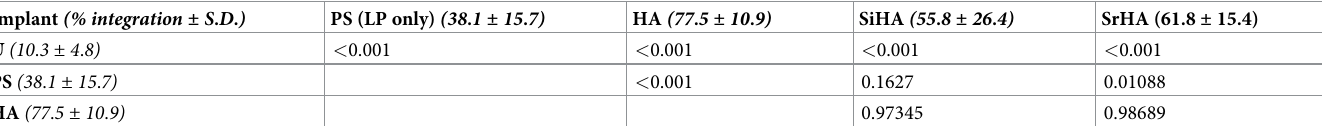
Table 3. p-values and percentage BIC (mean ± S.D.) for coating compared against uncoated, plasma spray coated, and electrochemical HA implants. Implants from both pore sizes were grouped together (plasma sprayed only results from larger pore size). U, uncoated PS, plasma sprayed HA; HA, electrochemical HA; SiHA, electrochemical SiHA; SrHA, electrochemical SrHA. Implant (% integration ± S . D .